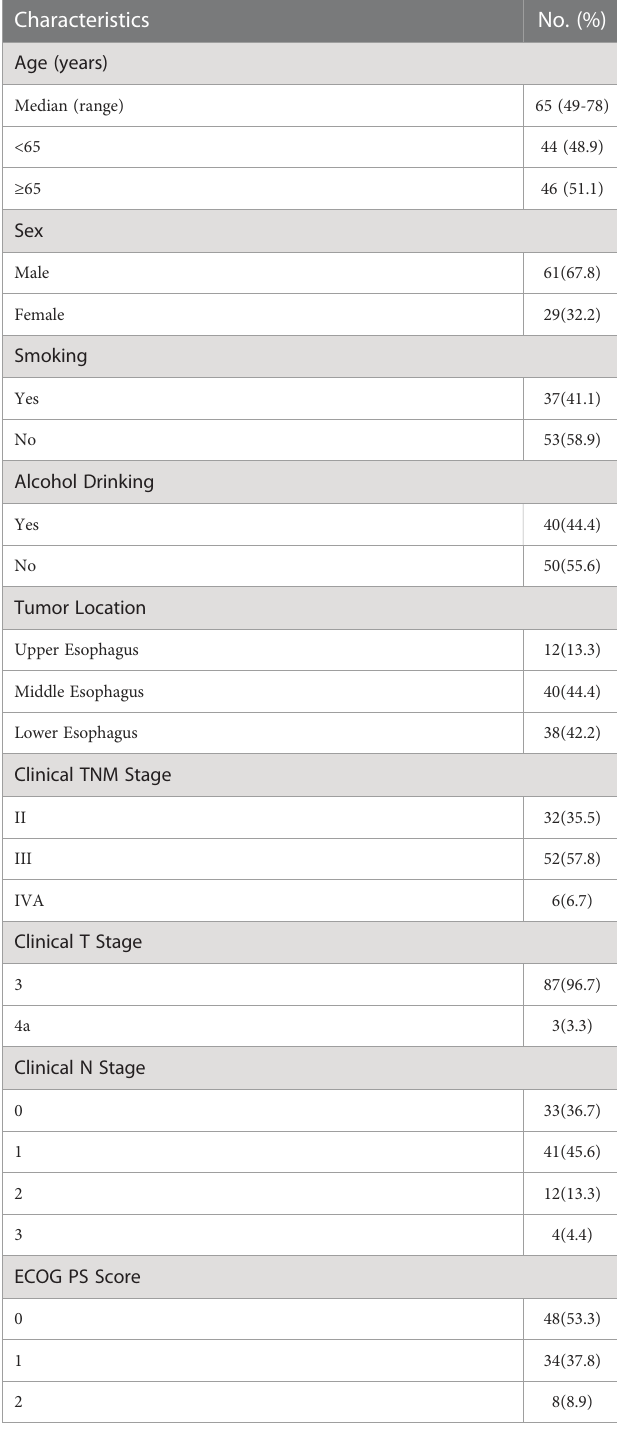
TABLE 1 Patient baseline